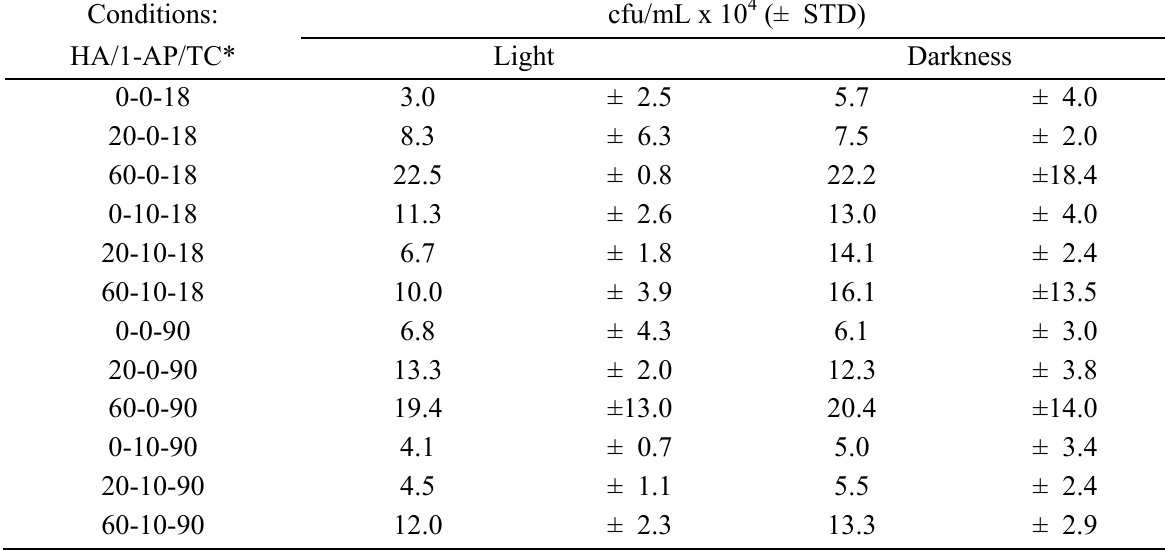
Table 1. Colony forming units per milliliter (cfu/mL)x10 4 (±STD) of viable heterotrophic bacteria after exposure to 1-AP in sunlight and darkness for 18 and 90 minutes in the presence or in the absence of